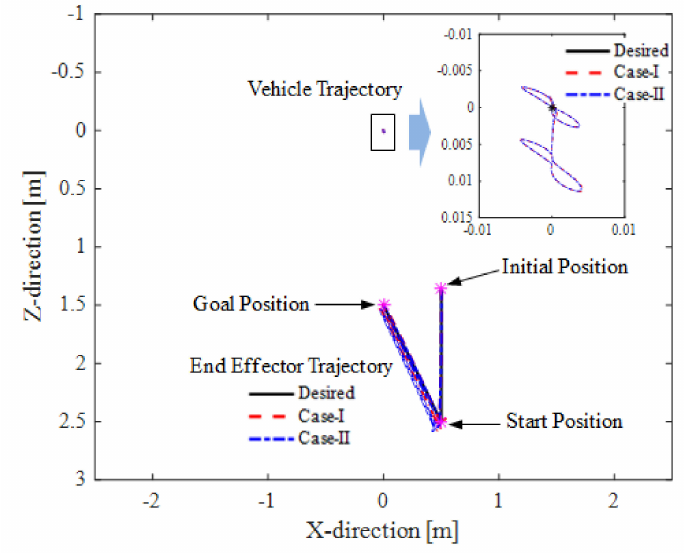
Figure 14. The trajectory of the position of the vehicle and the tip of end effector in vertical plane.